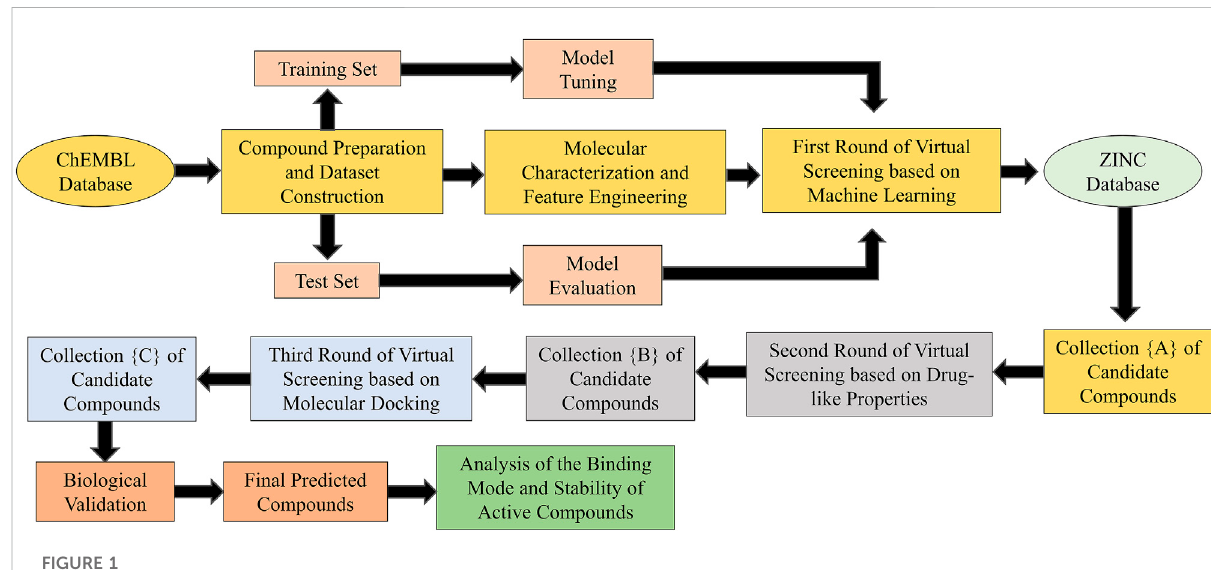
FIGURE 1 Architecture of the sequential virtual screening